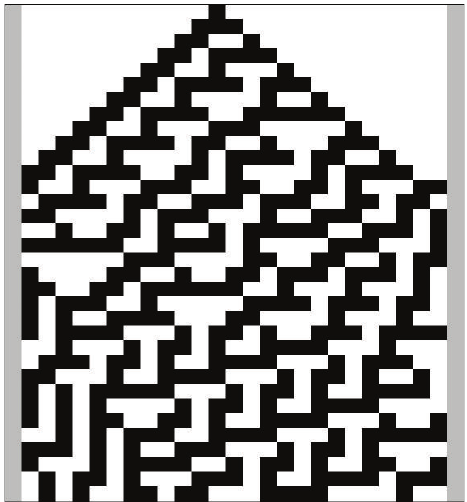
Figure 4: Example of one-dimensional cell automata. This is the result of rule 30 (00011110) that produces a shell-like pattern.